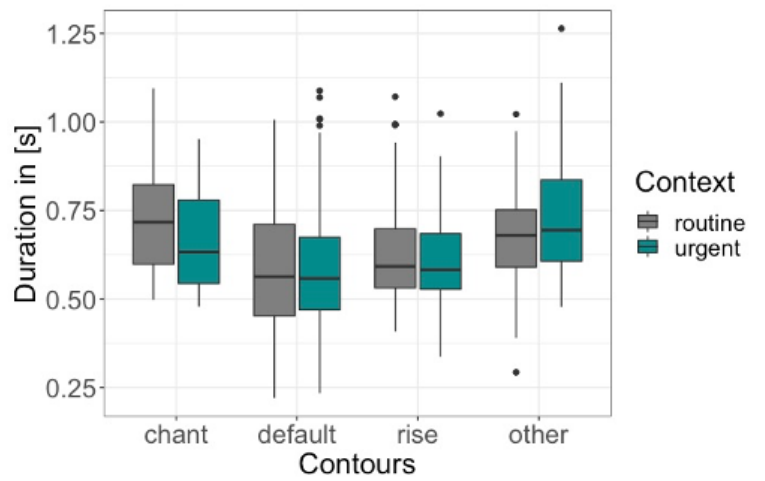
Figure 21. Word duration in the routine and urgent context across different calling melodies in CF.